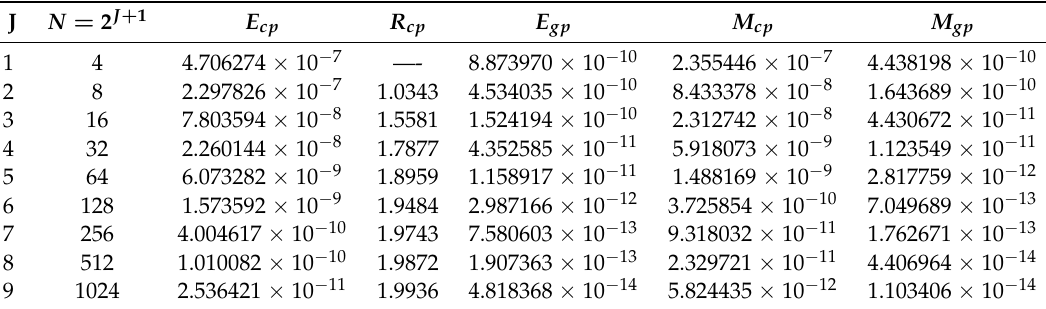
Table 2. E cp , R cp , E gp , M cp and M gp for Problem